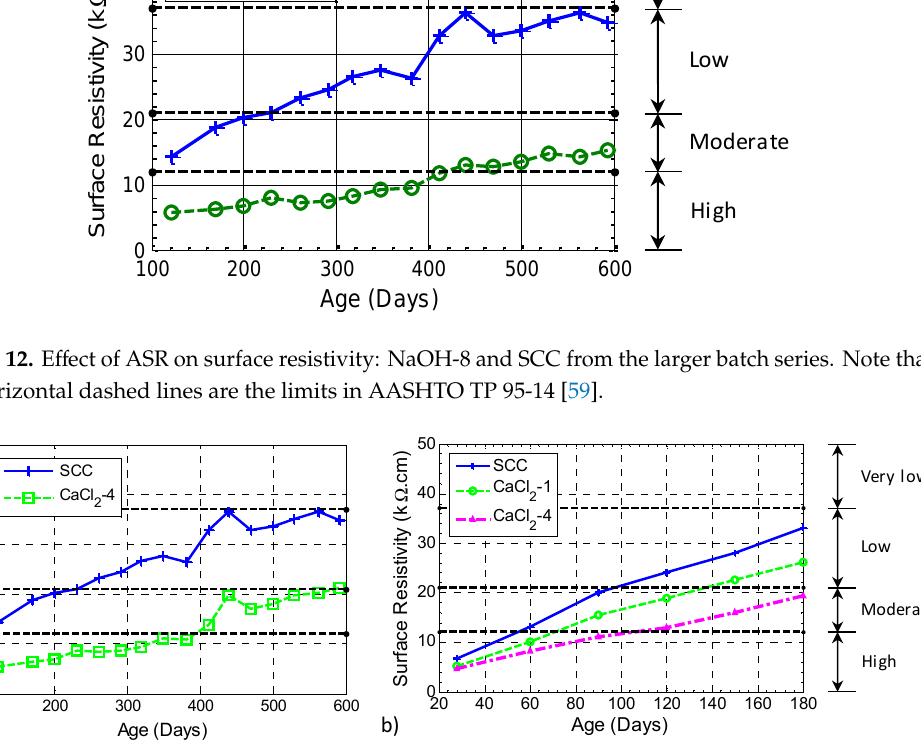
Figure 13. Effect of rebar corrosion on surface resistivity in ( a ) SCC and CaCl 2 -4 mixtures from the larger batch series and ( b ) CaCl 2 mixtures from the smaller batch series. Note that the horizontal dashed lines are the limits in AASHTO TP 95-14 [59].